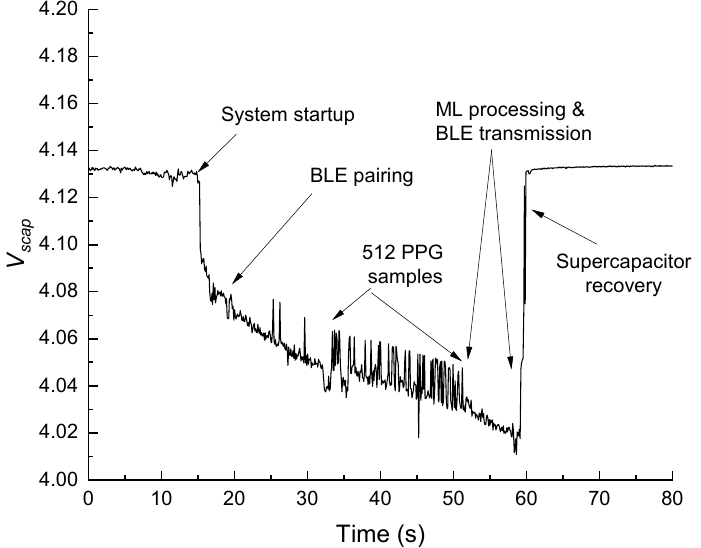
Figure 7. Measured supercapacitor voltage recovery after PPG sensing, processing, and BLE